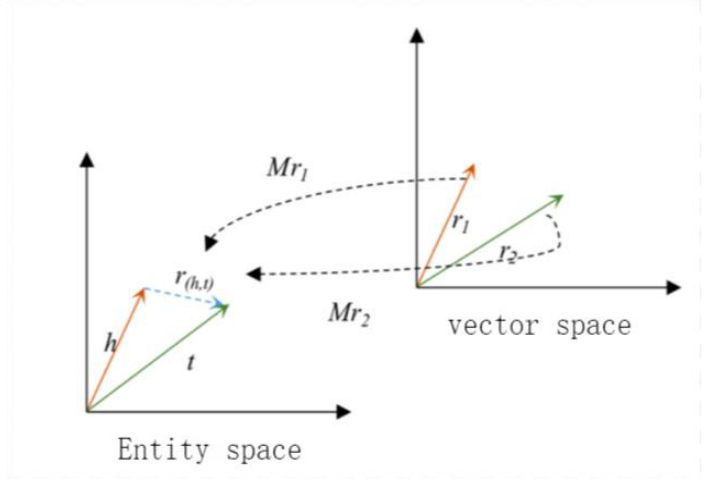
Figure 4. TransHR